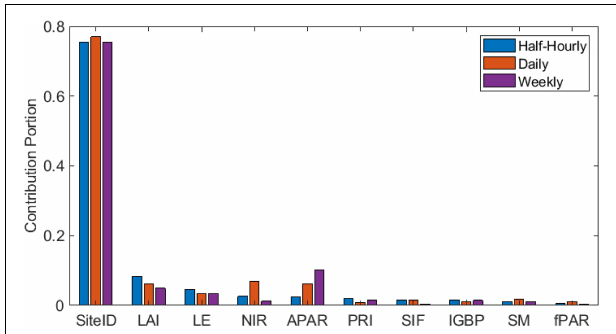
FIGURE 6 | Decision-tree model results showing the contribution portion of each variable in predicting GPP at the three timescales and the corresponding sample size (n), root mean square error (RMSE), and R 2 of the training and validation data sets.